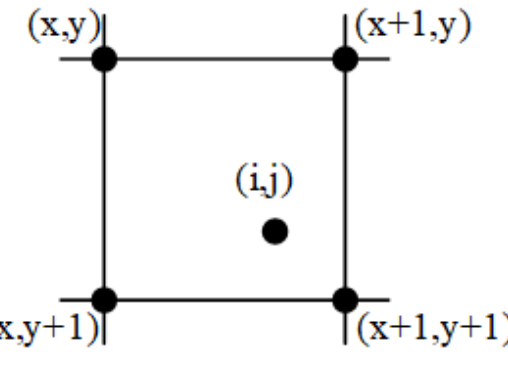
Fig. 3. Nearest Neighbour